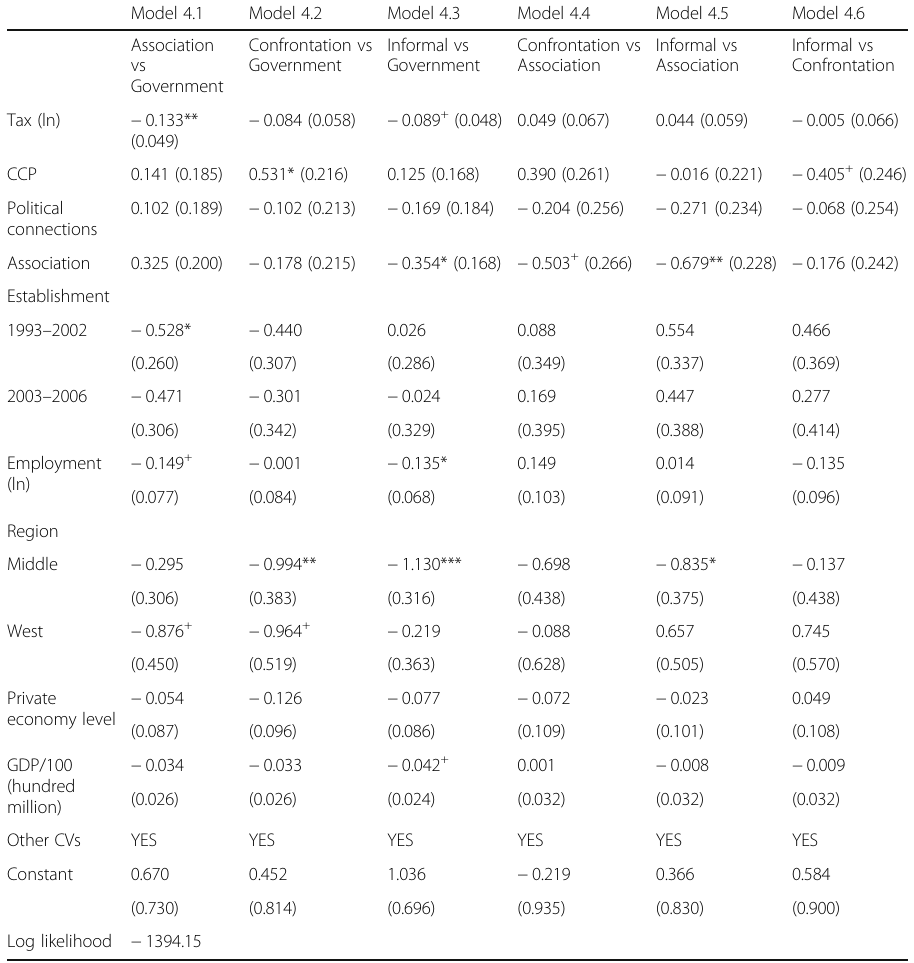
Table 4 MNL models predicting strategy selection ( N =